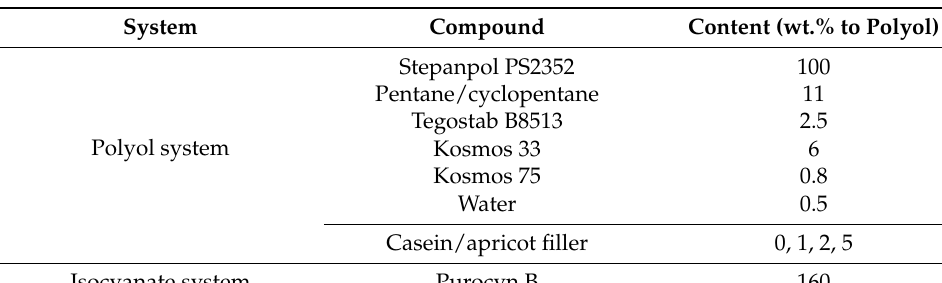
Table 1. Formulations of PUR composites prepared in the current study.